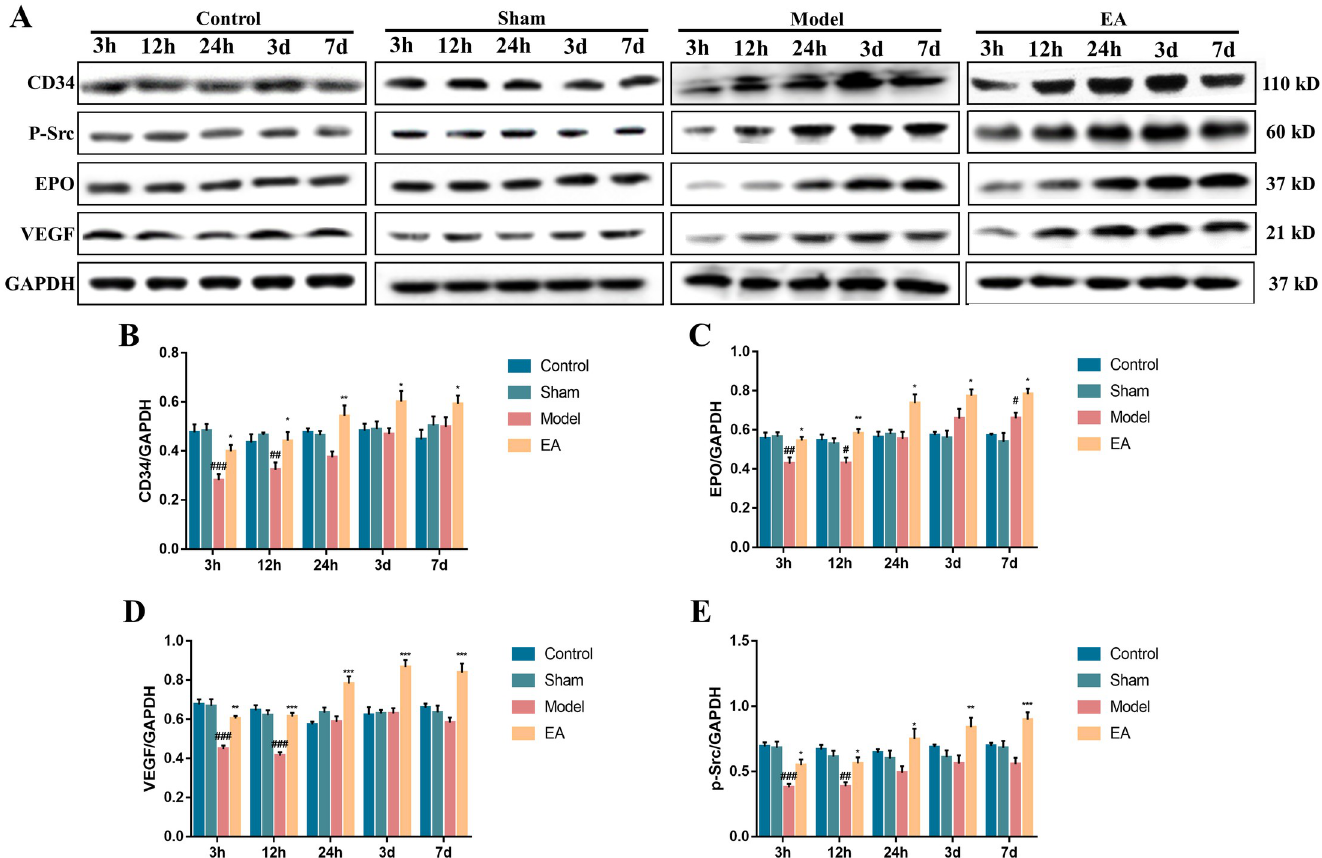
Fig 3. EA improved the expression of CD34, EPO, VEGF and p-Src proteins in the brain tissues of CIRI rats. (A) Representative blots showing the expression of CD34, EPO, VEGF and p-Src at different time points in the control, sham, model and EA groups. (B-E) Quantification of the expression level of CD34, EPO, VEGF and p-Src proteins (n = 5). Data were expressed as mean ± SEM. # P < 0.05, ## P < 0.01, ### P < 0.001 vs. sham group; � P < 0.05, �� P < 0.01, ��� P < 0.001 vs. model group.